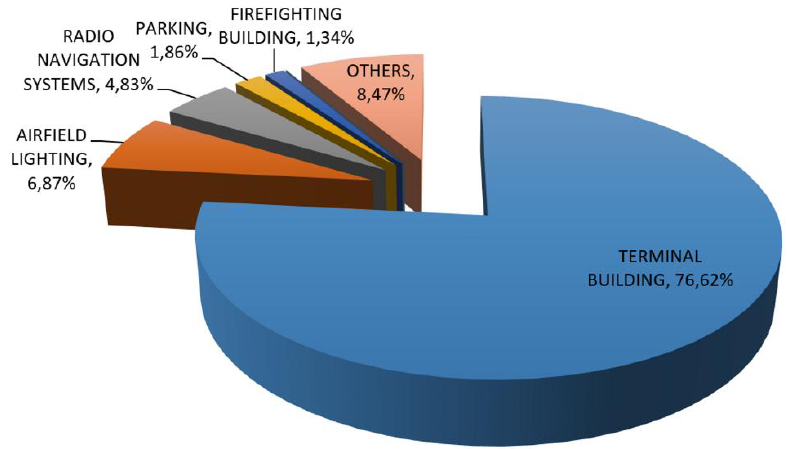
Figure 2. Energy consumption at Santander airport. Source: Airport Seve Ballesteros-Santander.